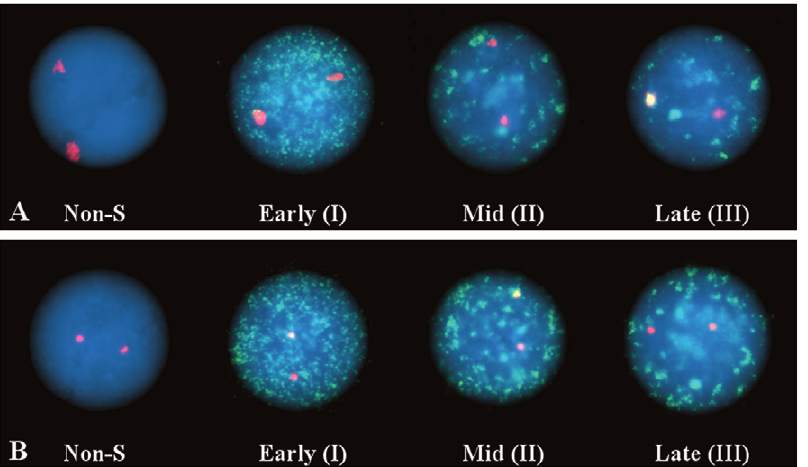
Figure 5. Heterochromatin configuration at different stages of the cell-cycle. BrdU pulse labelling (green), to visualise cells undergoing DNA synthesis (S phase), was used in conjunction with FISH with the D1Z1 probe (red) to identify a possible connection between the observed variability in the configuration of chromosome 1 juxtacentromeric heterochromatin and progression through the cell-cycle. Comparative tests were conducted in both ICF and controls. No differences were observed in the heterochromatin organisation when comparing B-cell nuclei in both ICF and control cells, with ‘‘conventional’’ (A) and ‘‘compact’’ (B) hybridisation patterns equally present in non-S phase and the various stages of the S phase of the cell-cycle. Examples above belong to a miscellanea of informative pictures collected from both ICF and control cells. S phase progression patterns as described in O’Keefe [23].